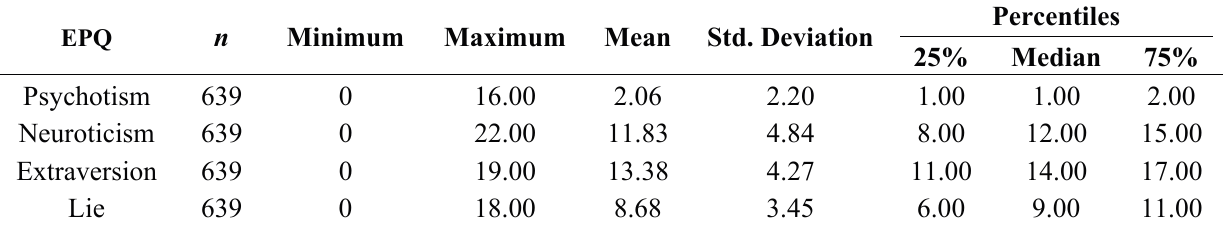
Table 5. Descriptive statistics for Eysenck Personality Questionnaire (EPQ) scales. EPQ